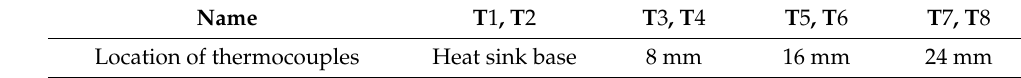
Table 3. Location of thermocouples.